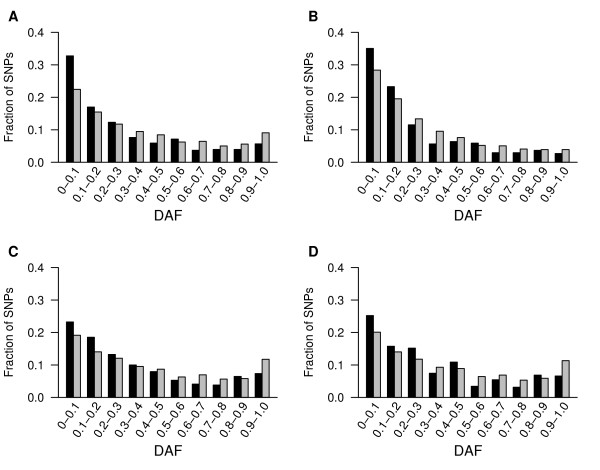
DAFs are lower for SNPs in CSSs than in flanking sequences. Derived allele frequencies (DAFs) were calculated in bin frequencies of width 0.1 for four HapMap populations: A: CEU; B: YRI; C: JPT; D: CHB. Black bars represent data for SNPs in CSSs and gray bars indicate their flanking sequences.